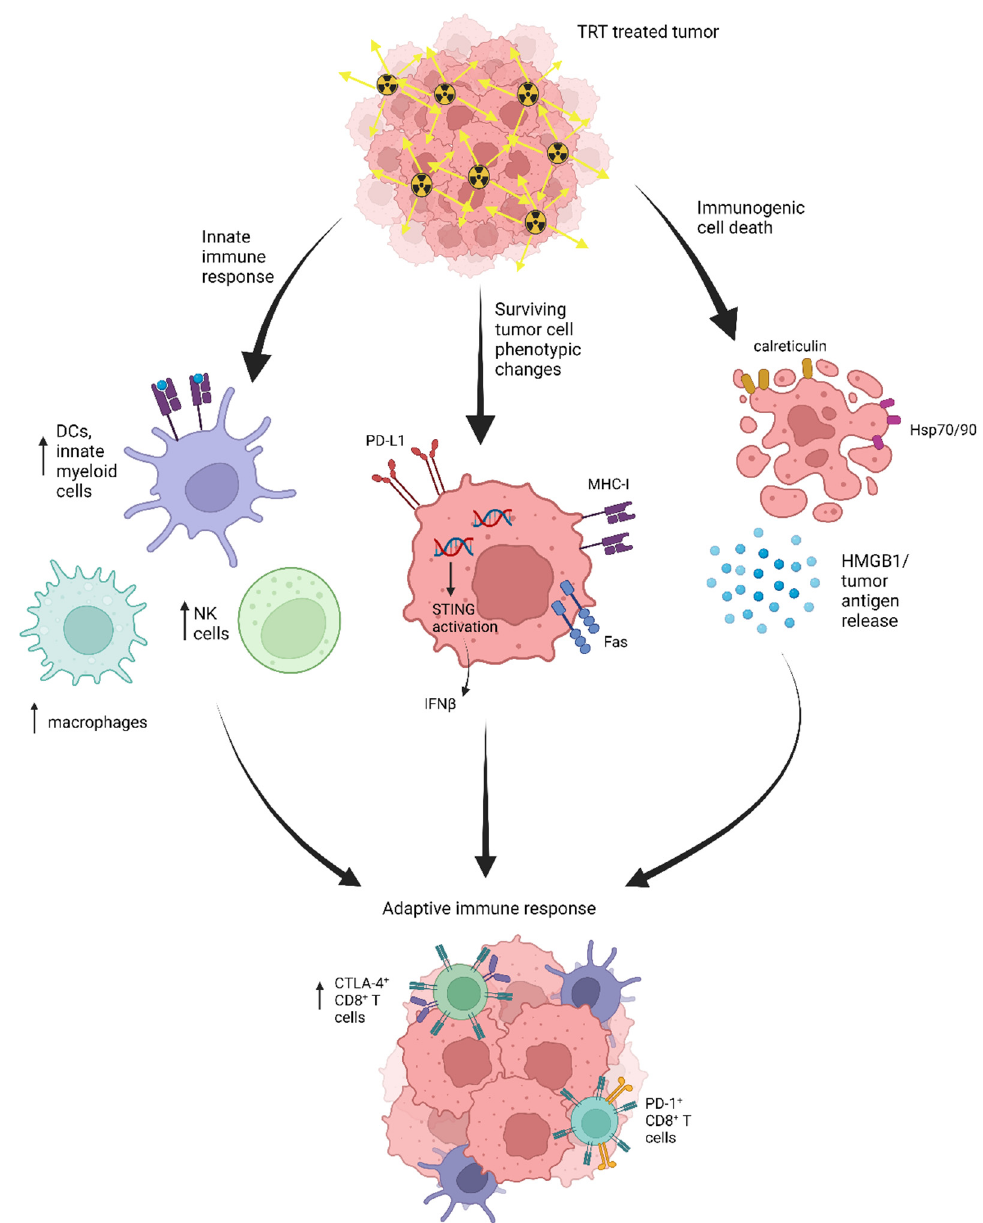
Figure 2. Schematic of immune activation mechanisms by targeted radionuclide therapy (TRT). Initially, tumor cells treated by TRT undergo immunogenic cell death (ICD), releasing tumor specific antigens in the process, while other surviving cells undergo phenotypic changes. These include increased PD-L1, MHC-I, and Fas expression, as well as IFN β production through activation of the cGAS/STING pathway. Additionally, innate immune cell populations increase in the tumor microenvironment (TME), including dendritic cells (DCs), natural killer (NK) cells, macrophages, and other innate myeloid cells. Finally, a robust adaptive immune response is generated, characterized by increased CTLA-4 + CD8 + and PD-1 + CD8 + T cell populations, as well as effector memory T cell populations, and both increases and decreases in regulatory T cell populations. Created with BioRender.com.